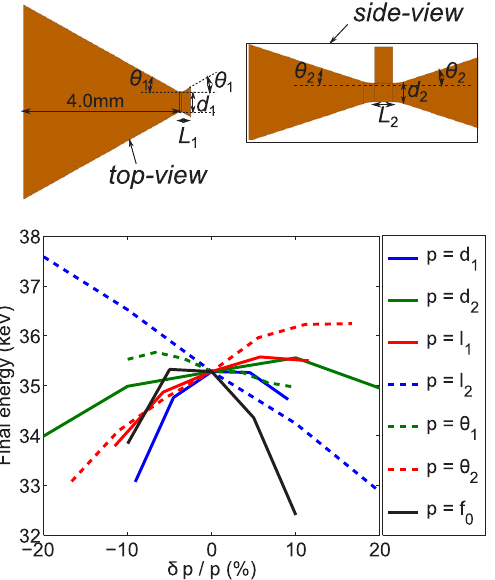
FIG. 5. Results of the sensitivity study for the horn gun. The legend on the left of the plot introduces the studied